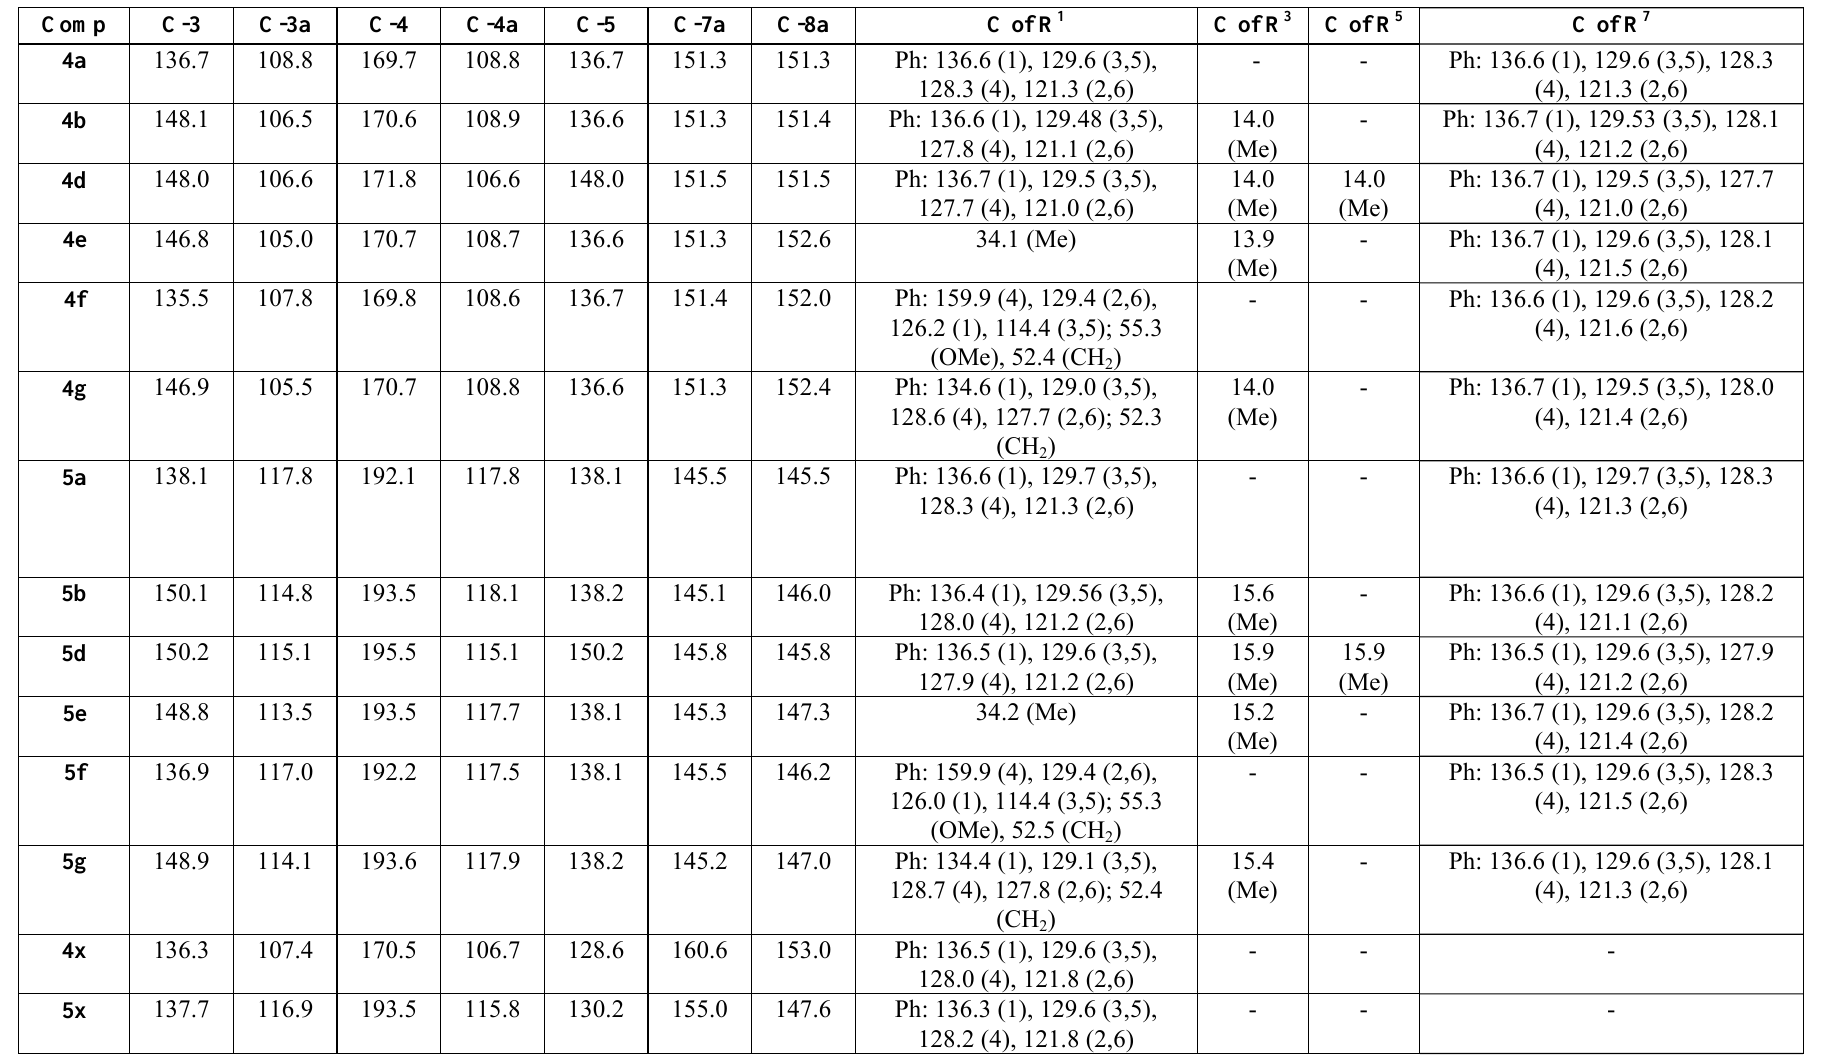
Table 3. 13 C-NMR chemical shifts of 4a - b , 4d - g , 5a - b , 5d - g , 4x and 5x ( δ in ppm, solvents as listed in Table 2